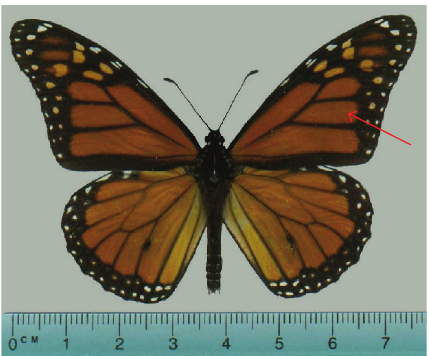
Figure 1: Monarch butterfly, D. plexippus . This individual, a male, was captured in September 2005 by AKD. Arrow indicates the cell used for measuring color in this